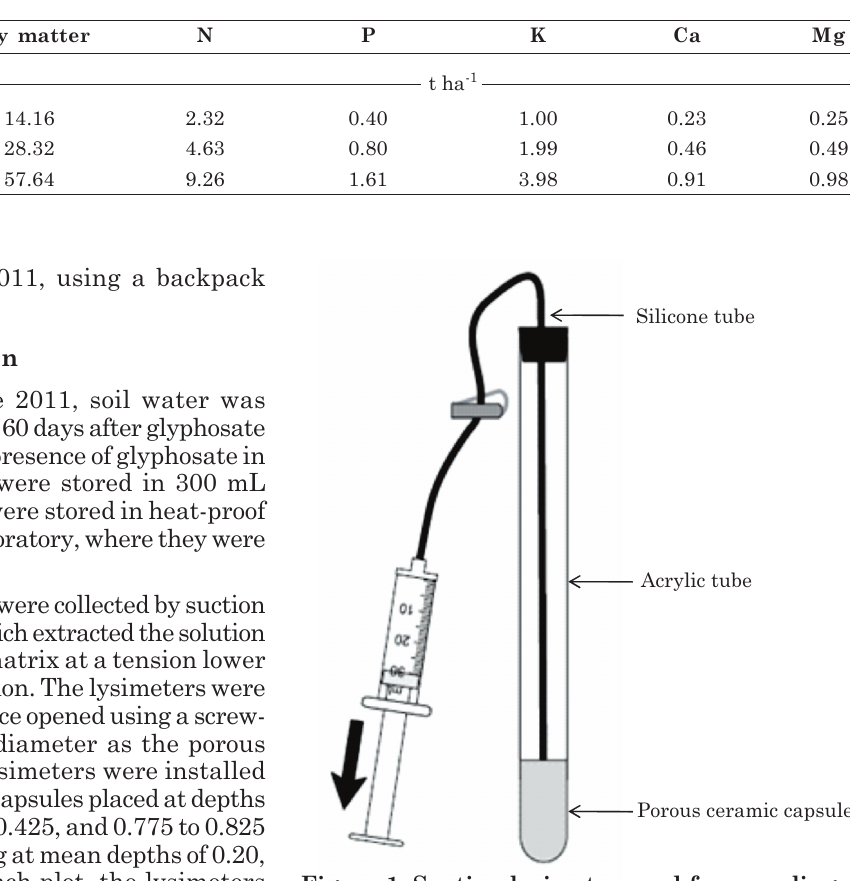
Table 1.Total amount of dry matter from organic matter and nutrients applied through pig slurry over the 12 years of